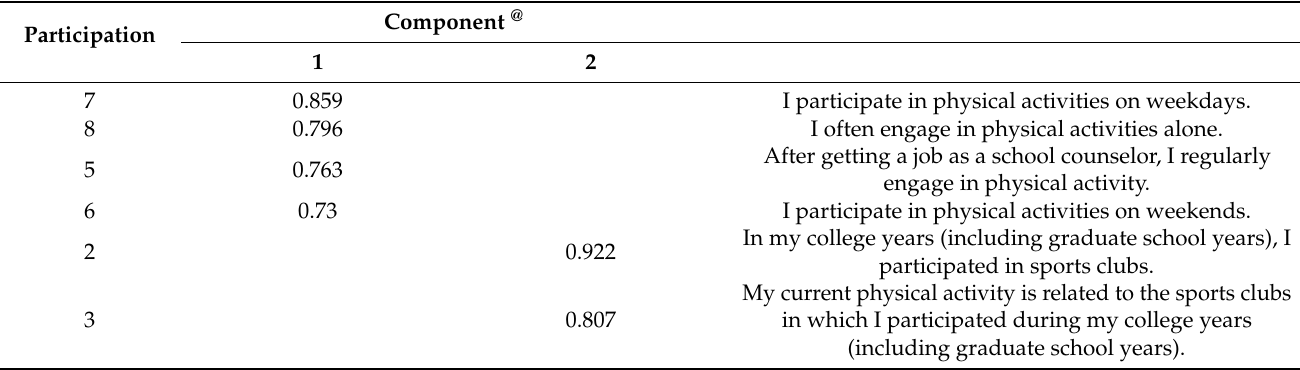
Table 1. The questionnaire items of physical activity participation, perceived barriers, and attitude toward physical